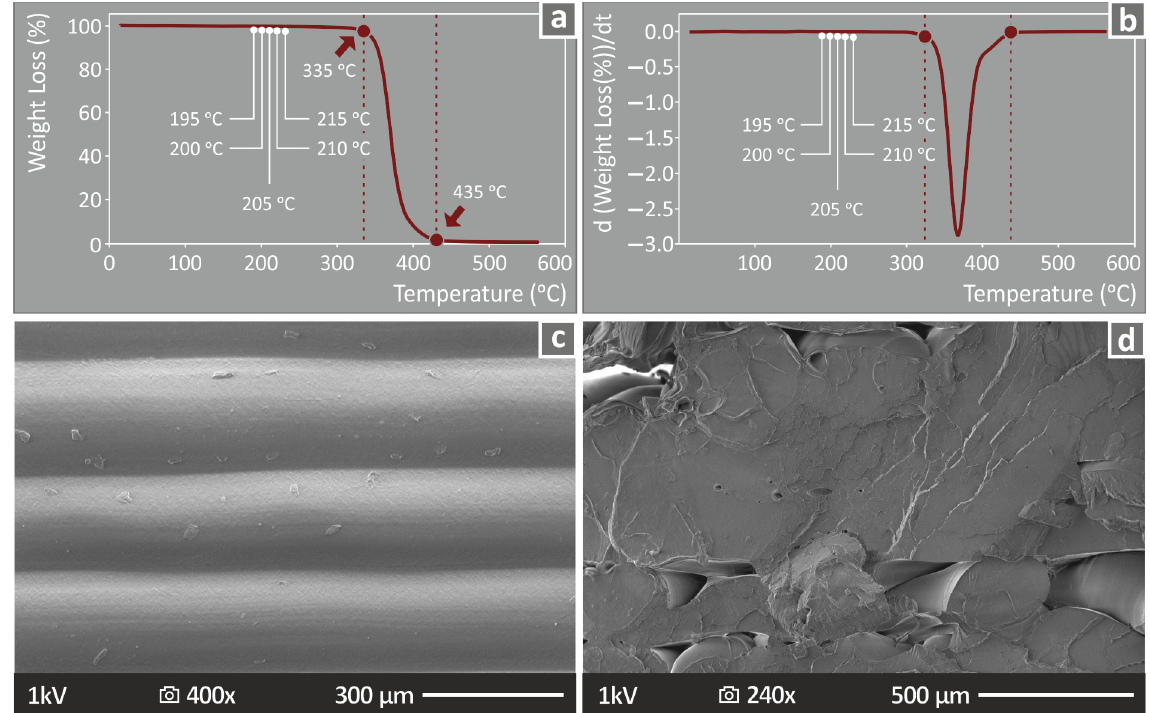
Figure 4. ( a ) Weight loss (%) vs. temperature (°C) graph produced on the TGA measurements of the specific PLA grade studied herein, ( b ) corresponding d(weight loss)/dt graph produced during the DSC measurements, and SEM images from ( c ) the side surface, ( d ) the fracture surface of a randomly selected sample, after the experimental testing with flexural loading. Table 1. Taguchi L25 Design: Control parameters and